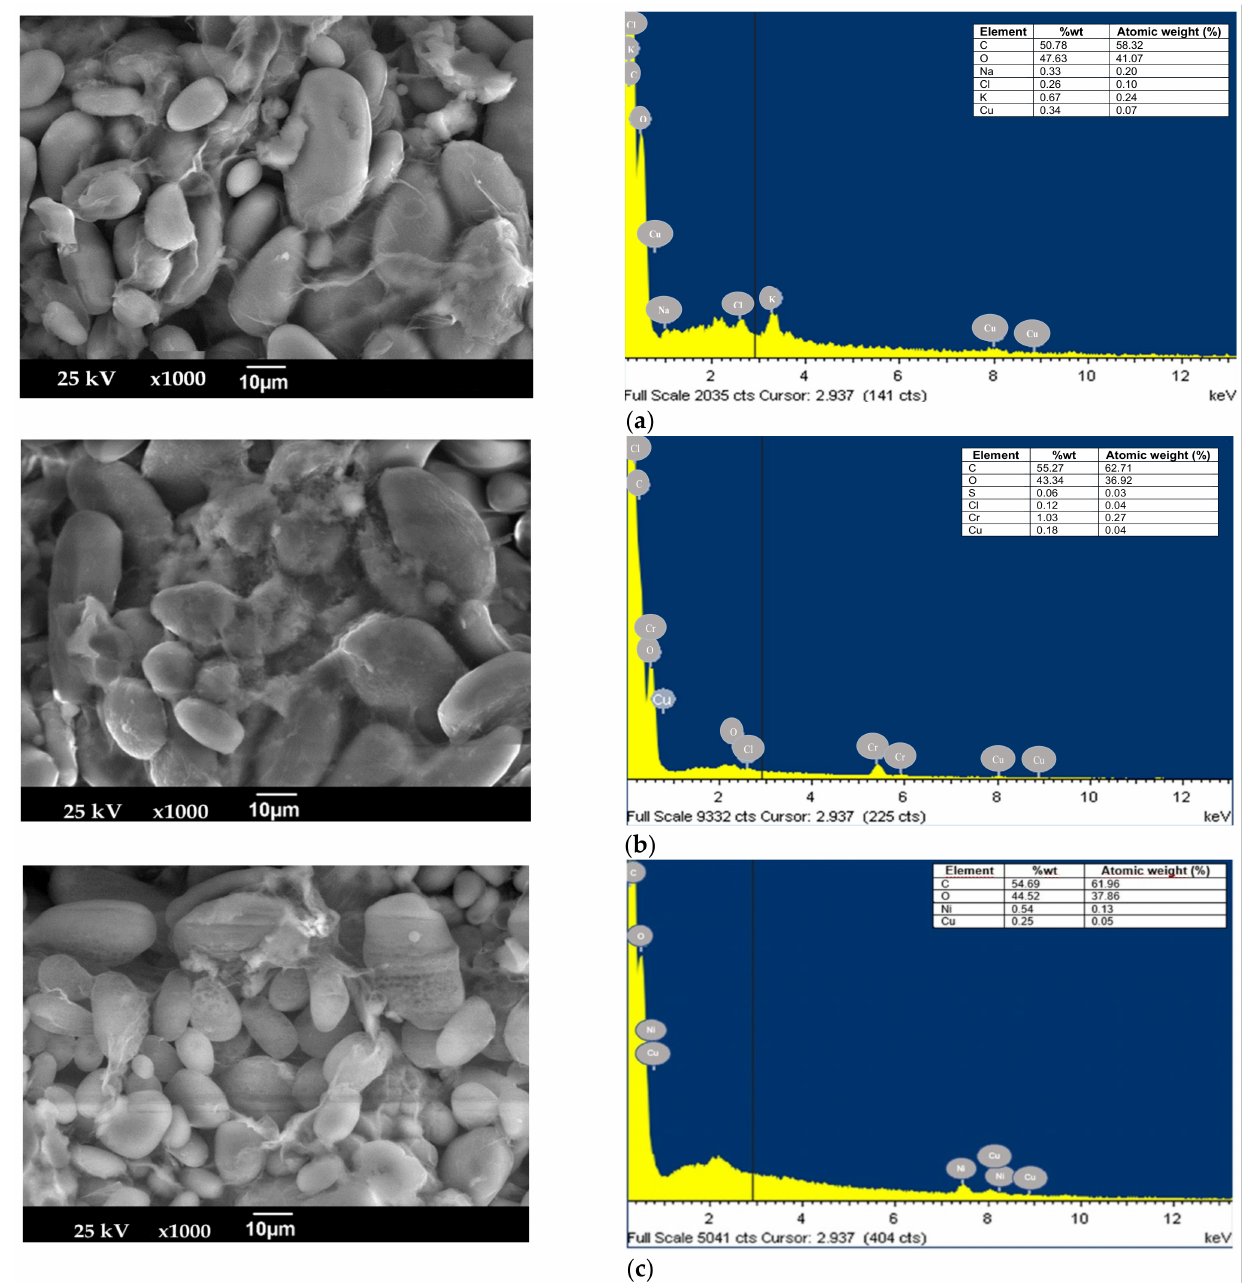
Figure 3. SEM micrographs and EDS of the PSR ( a ) natural and after adsorption of ( b ) Cr (VI) and ( c ) Ni